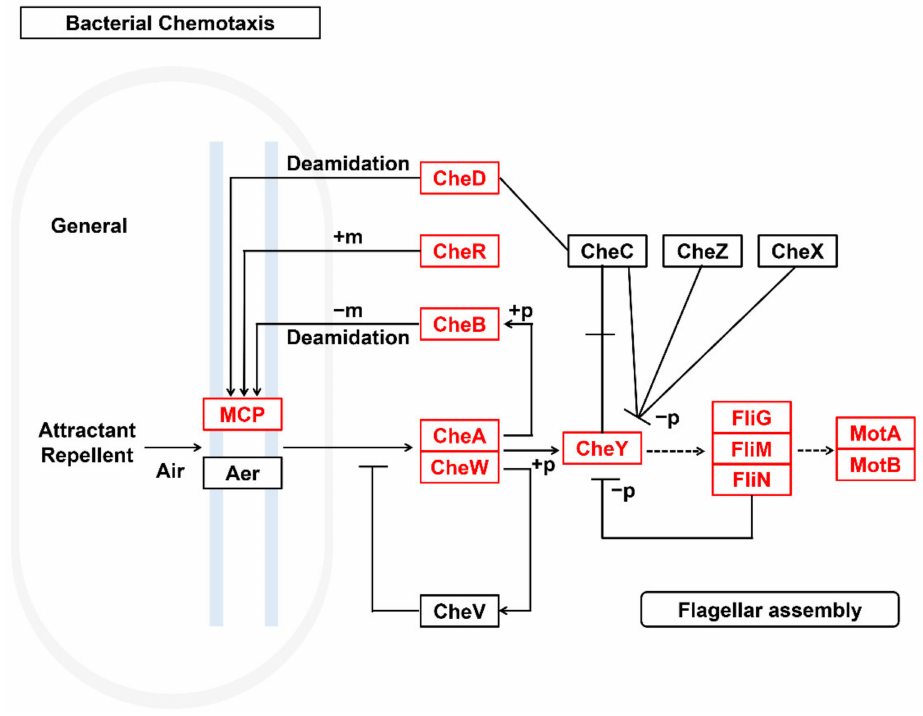
Figure 5. Sphingomonas sp. bacterial chemotaxis